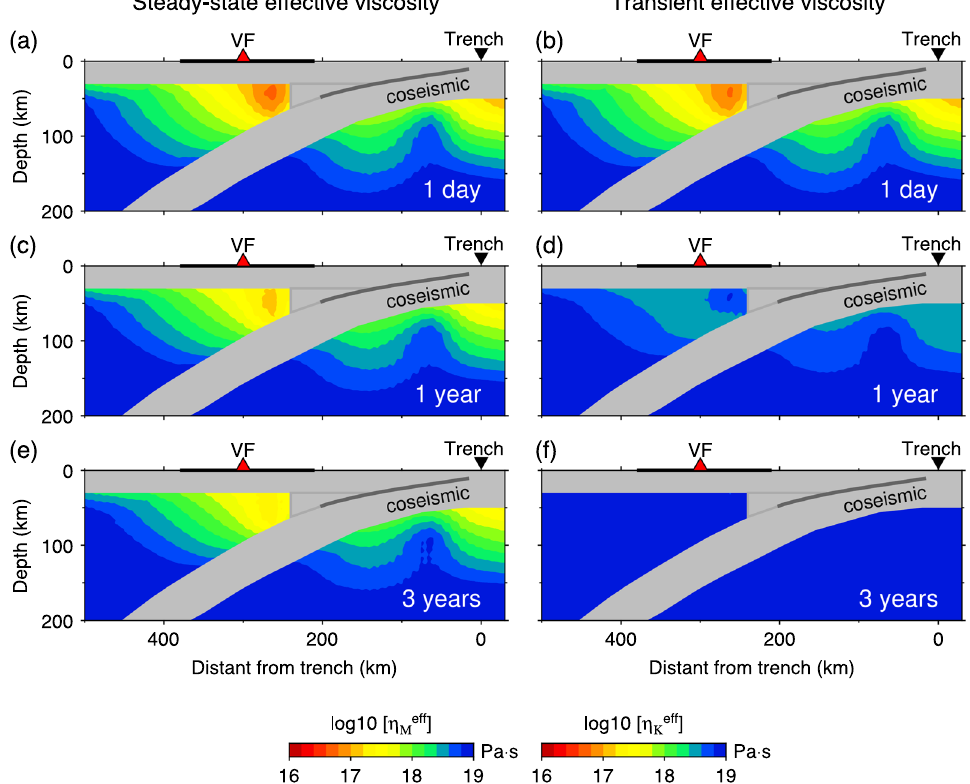
Fig. 5 The postseismic evolution of effective viscosity in the power-law base model. The effective viscosities of steady-state (Maxwell element; left panel) and transient (Kelvin element; right panel) deformation are shown for a–b 1 day, c–d 1 year, e–f 3 years after the